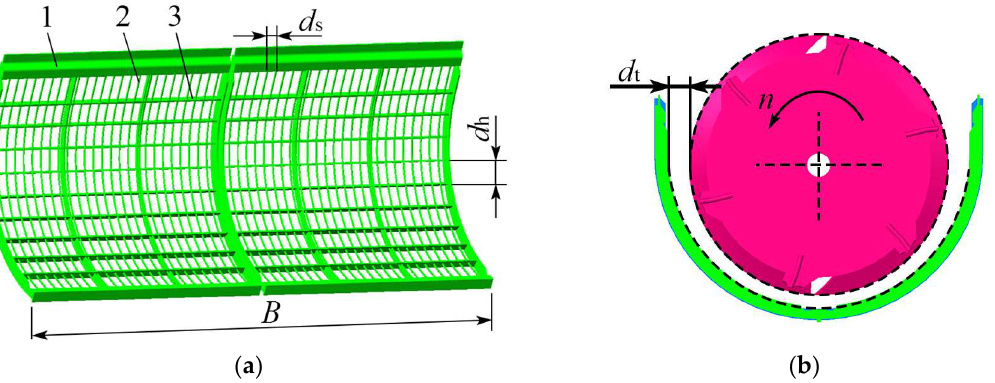
Figure 7. Schematic diagram of the structure of the narrow grid recess: ( a ) Concave plate size. ( b ) Concave plate-clad corners. (1) Narrow grating concave sieve. (2) Grating bars. (3) Horizontal spacer. Note: d s is the spacing between the grating bars in mm; d h is the spacing between the horizontal dividers in mm; d t is the gap between the concave plates in mm.